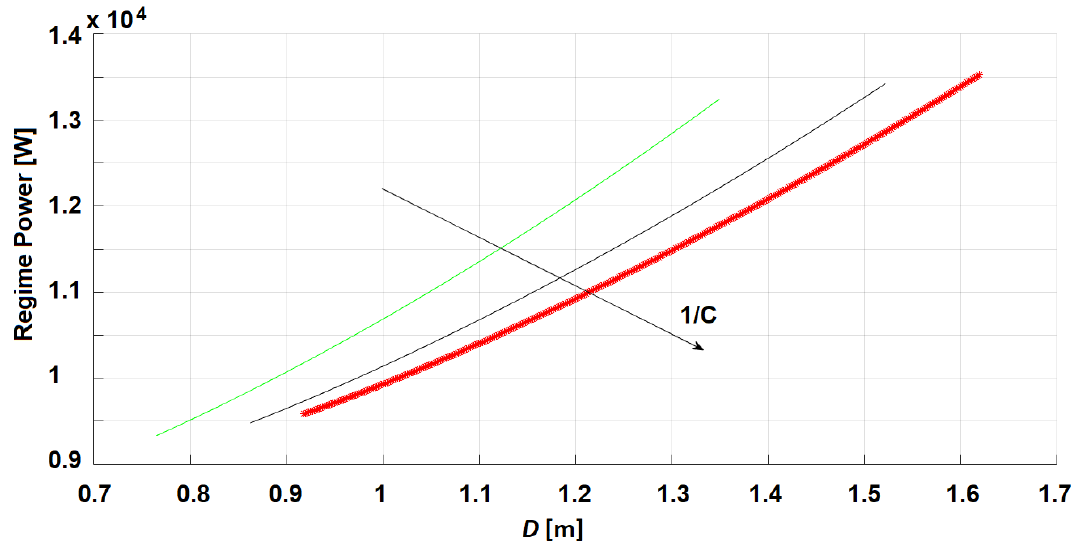
Figure 9. Regime power vs. shaft spacing distance ( D ) and index of compactness (C).